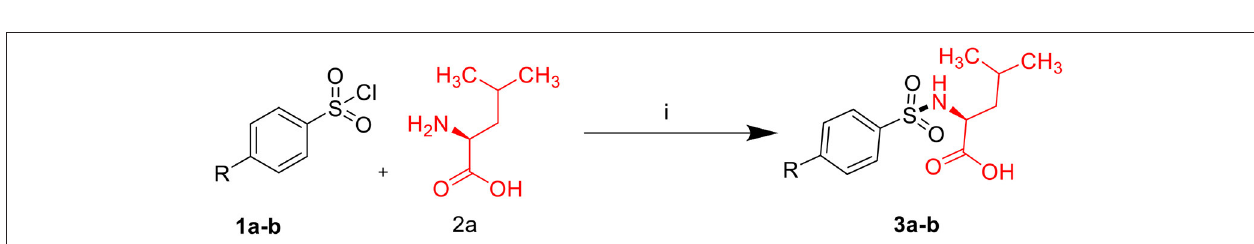
Lipinski’s rule of